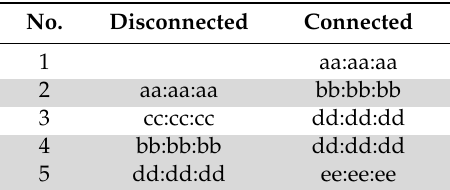
Table 2. Example of continuity.